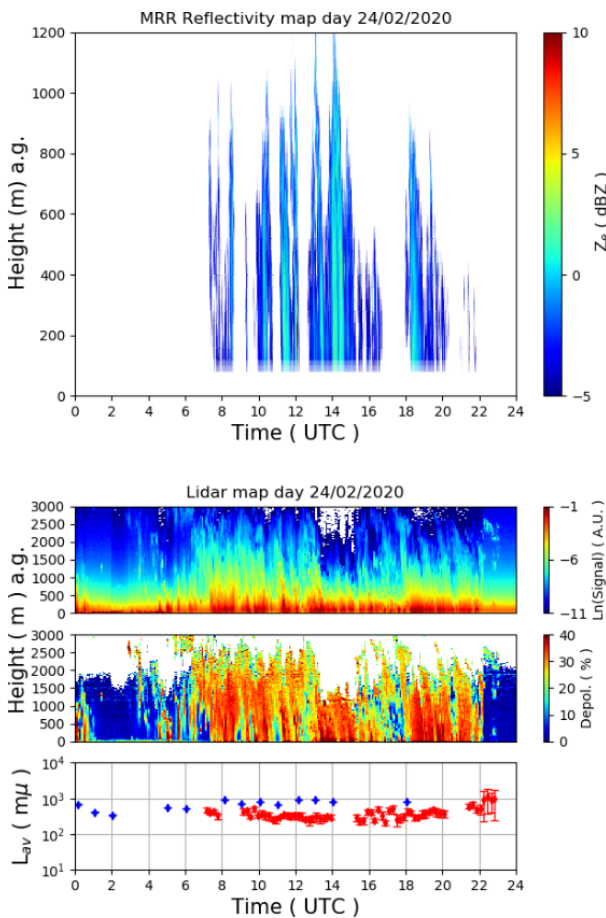
Figure 18. As in Fig. 17, but for the dayof 24 February 2020.